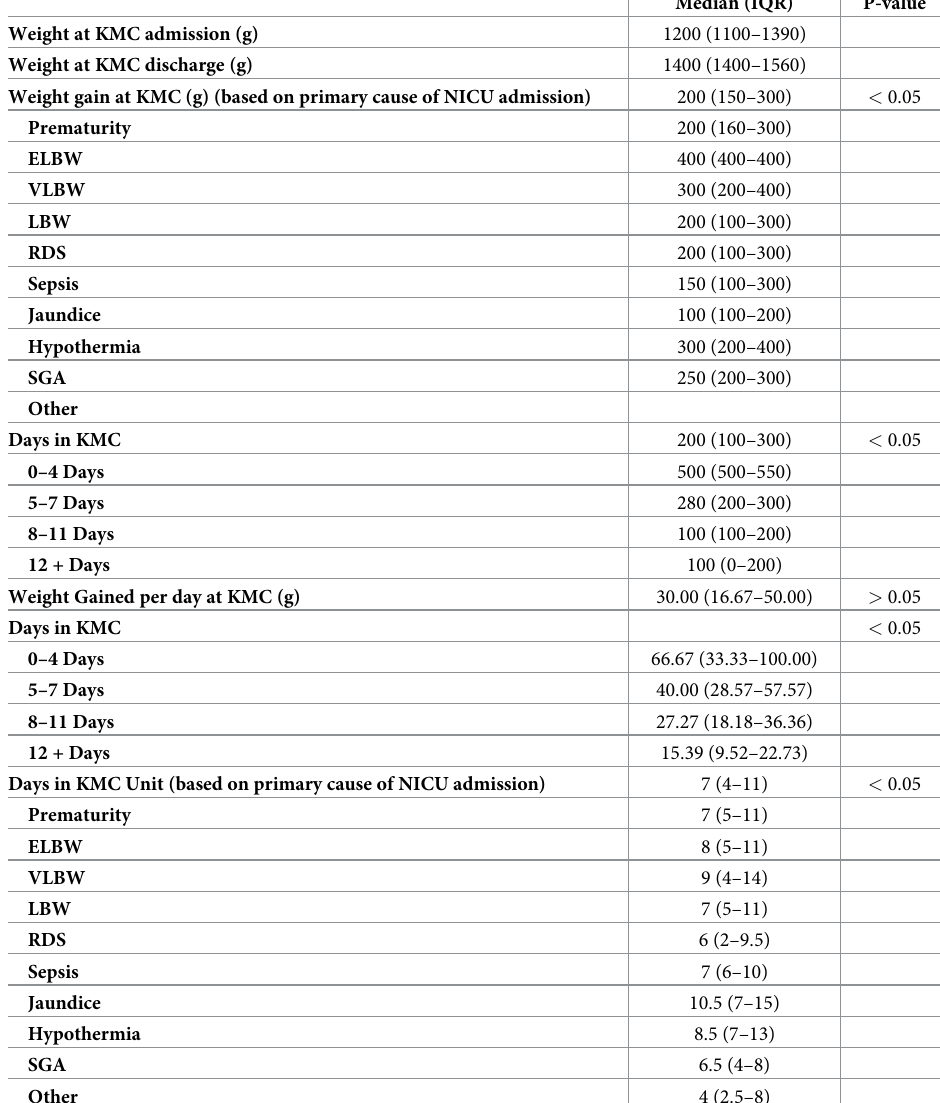
Table 5. Weight gain among neonates admitted to the KMC room (n =